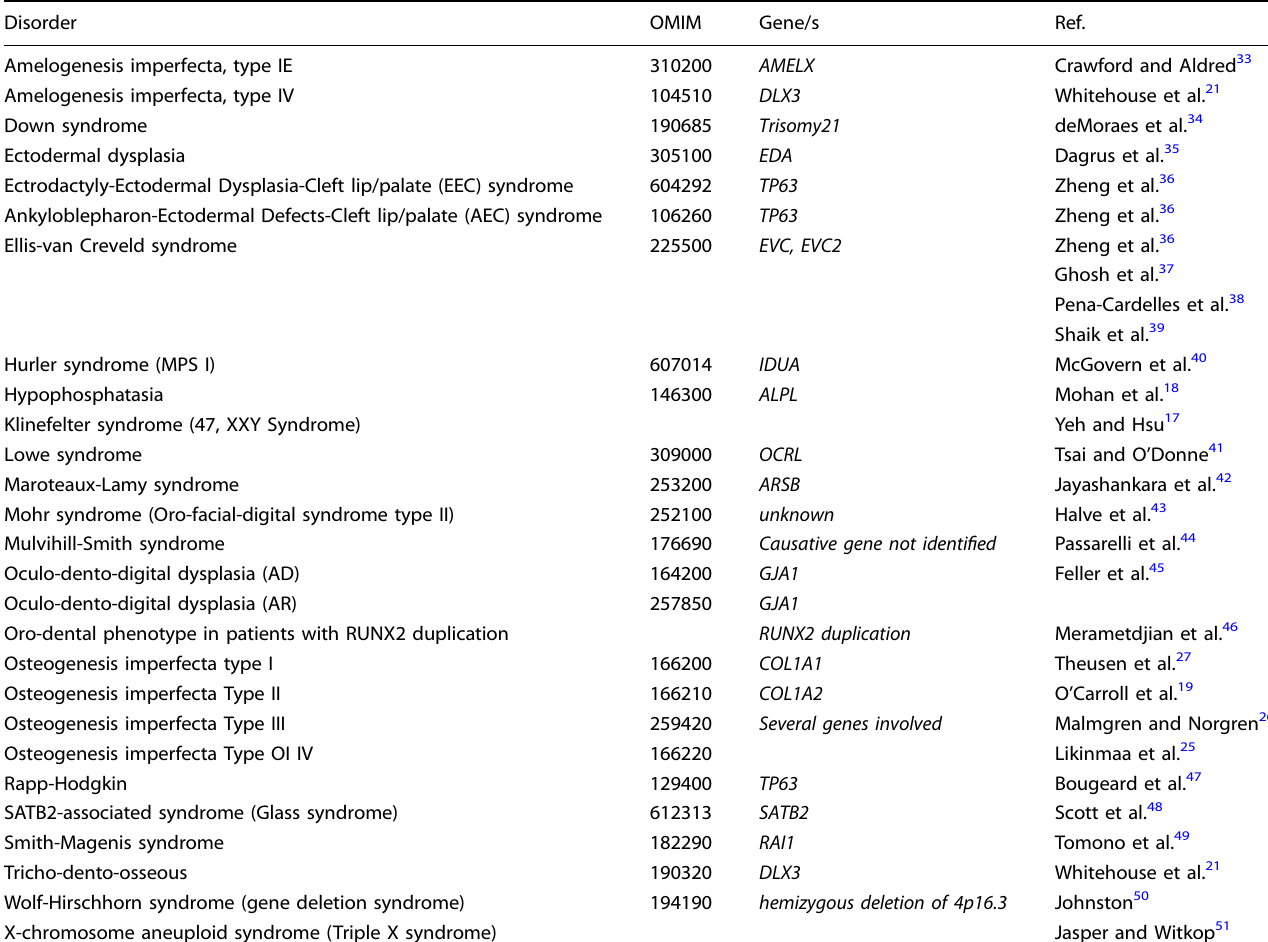
Table 1. Genetic syndromes in which taurodontism has been